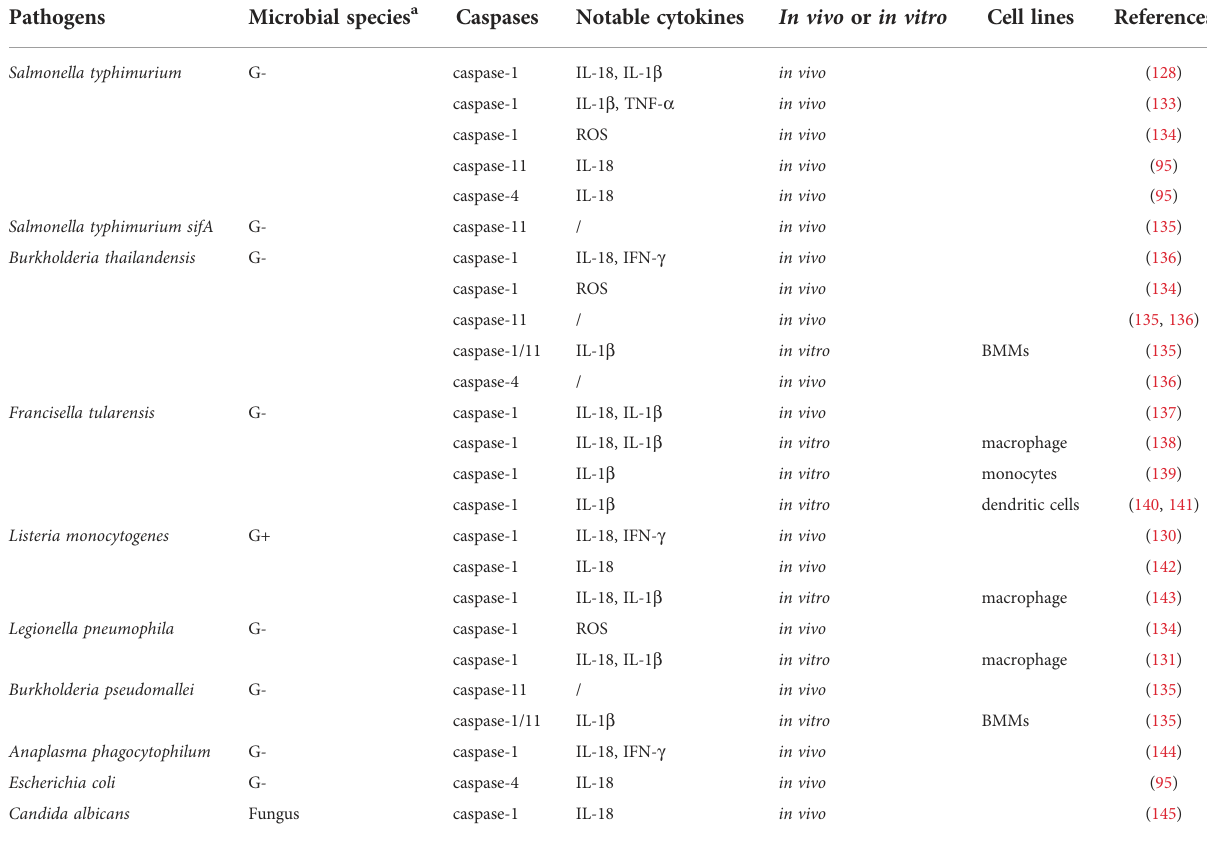
TABLE 2 In fl ammatory caspases are involved in defense against multiple pathogen